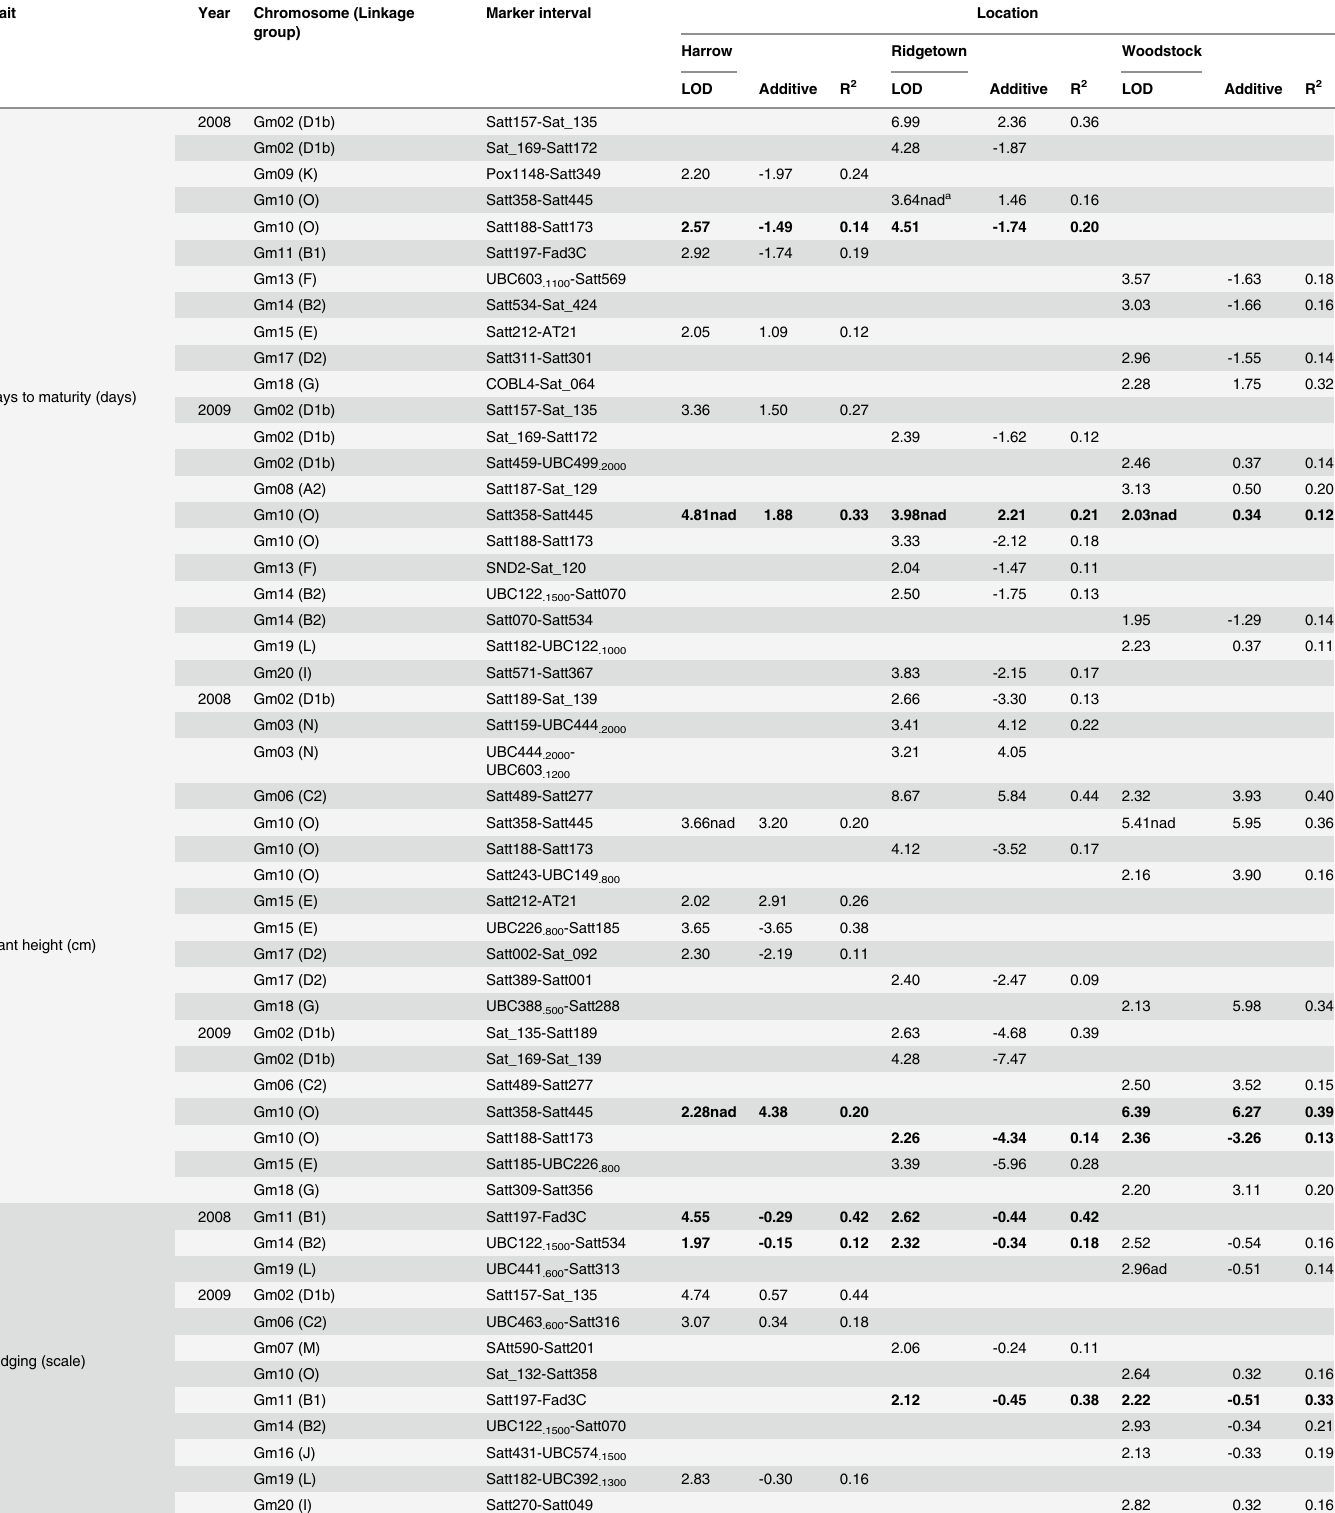
Table 4. Quantitative trait loci (QTL) for agronomic and fiber compositional traits in 50 selected RG10 x OX948 recombinant inbred lines (RILs) in six environments.